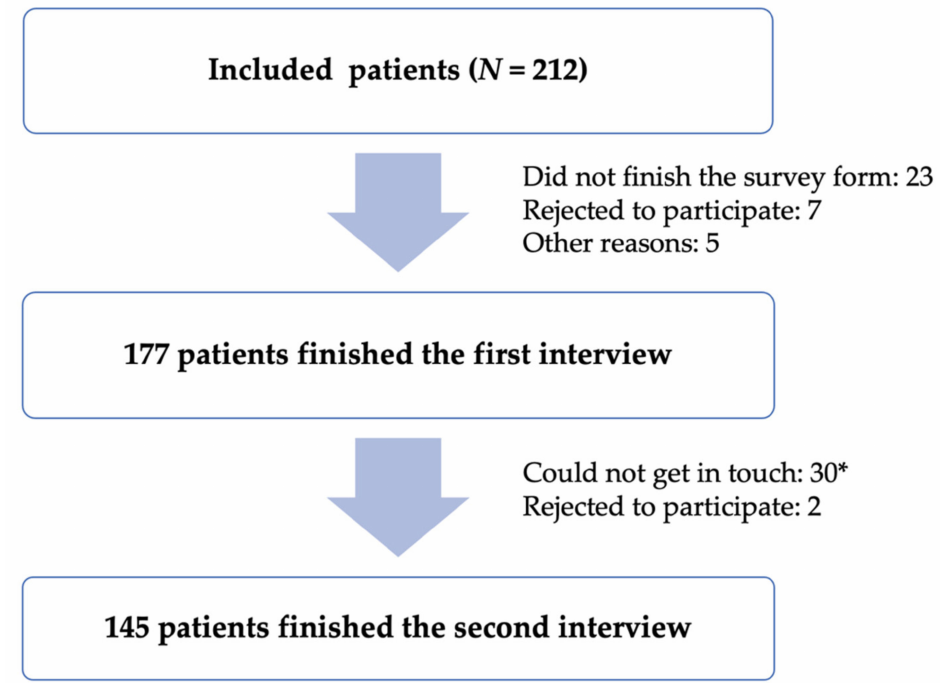
Figure 1. Sample selection and tracking process. (*) The patient will be considered not contacted if the researcher calls seven times without answering (the first day: three times every 30–60 min and four consecutive days thereafter: once a day) or if the patient reads the wrong phone